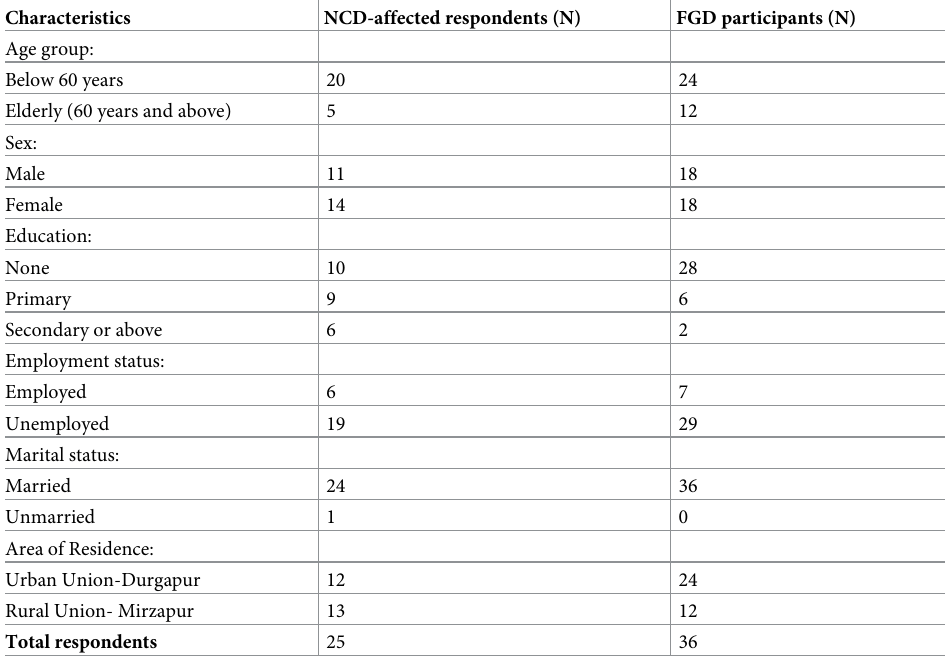
Table 1. Characteristics of respondents affected by non-communicable disease and focused group discussion (FGD) participants.